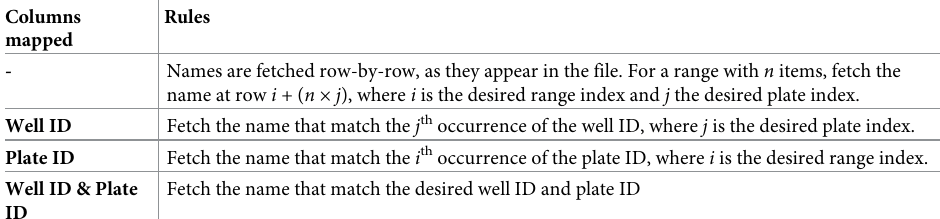
Table 1. Rules used for the resolution of name for a given range index from a Definition file, based on the map- ping configuration. Columns